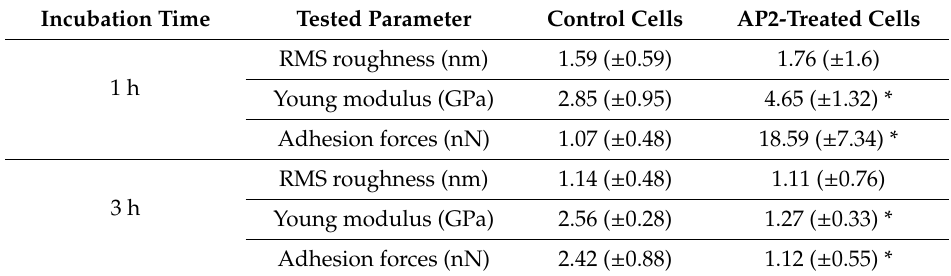
Table 2. Nanomechanical properties of C. albicans cell surface after treatment with G. mellonella